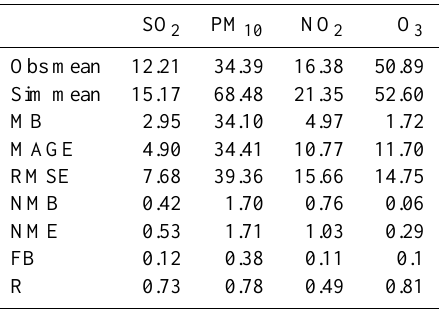
Table 4. Model evaluation at the Layer-3 of IAP tower (SO 2 , NO 2 and O 3 unit:ppbv; PM 10 unit: µgm − 3 ) .